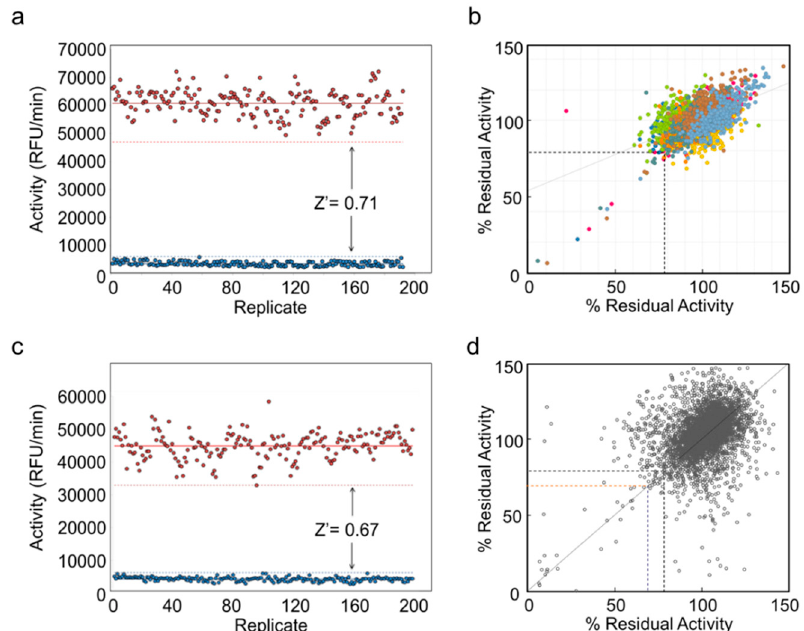
Figure 2. Pilot screens for inhibitors of Ng PatB and Sa OatA. ( a , c ) Determination of Z’ factors for the HTS assays of Ng PatB ∆ 69 and Sa OatA ∆ 435 , respectively. ( b,d ) HTS of Bioactive Subset of the Canadian Compound Collection for inhibitors of Ng PatB ∆ 69 and Sa OatA ∆ 435 , respectively.